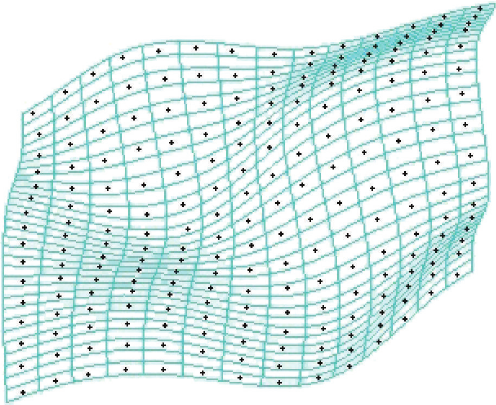
Figure 7: First check